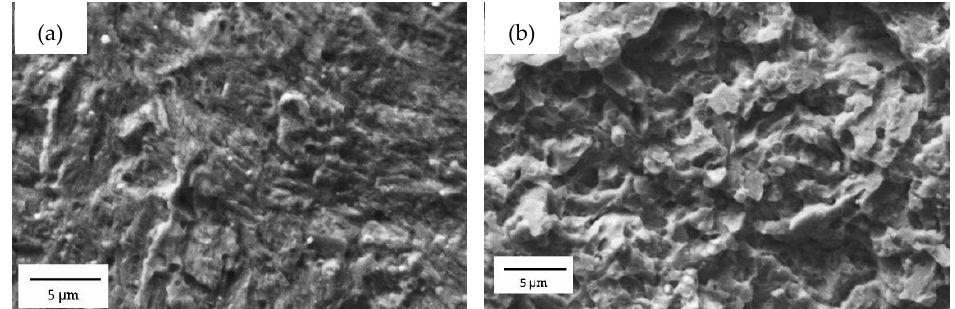
Figure 14. SEM-SE micrographs of smooth propagation zone ( a ) and rough final failure zone ( b ) of an unnotched sample.